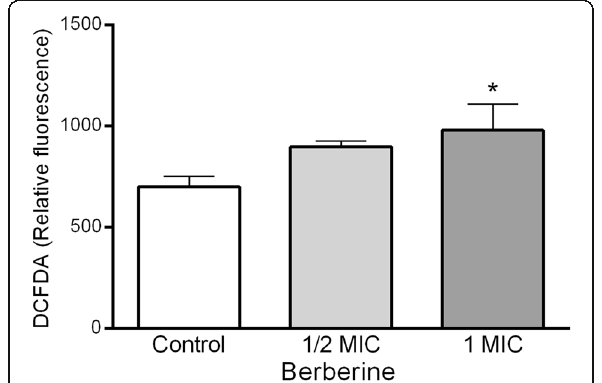
Fig. 8 Changes in ROS generation upon berberine treatment of C. albicans cells. Berberine at sub MIC concentration induced ROS production. The augmentation of ROS production reached statistical significance upon the treatment with MIC concentration of berberine. The data are presented as mean values ± SD (*p <